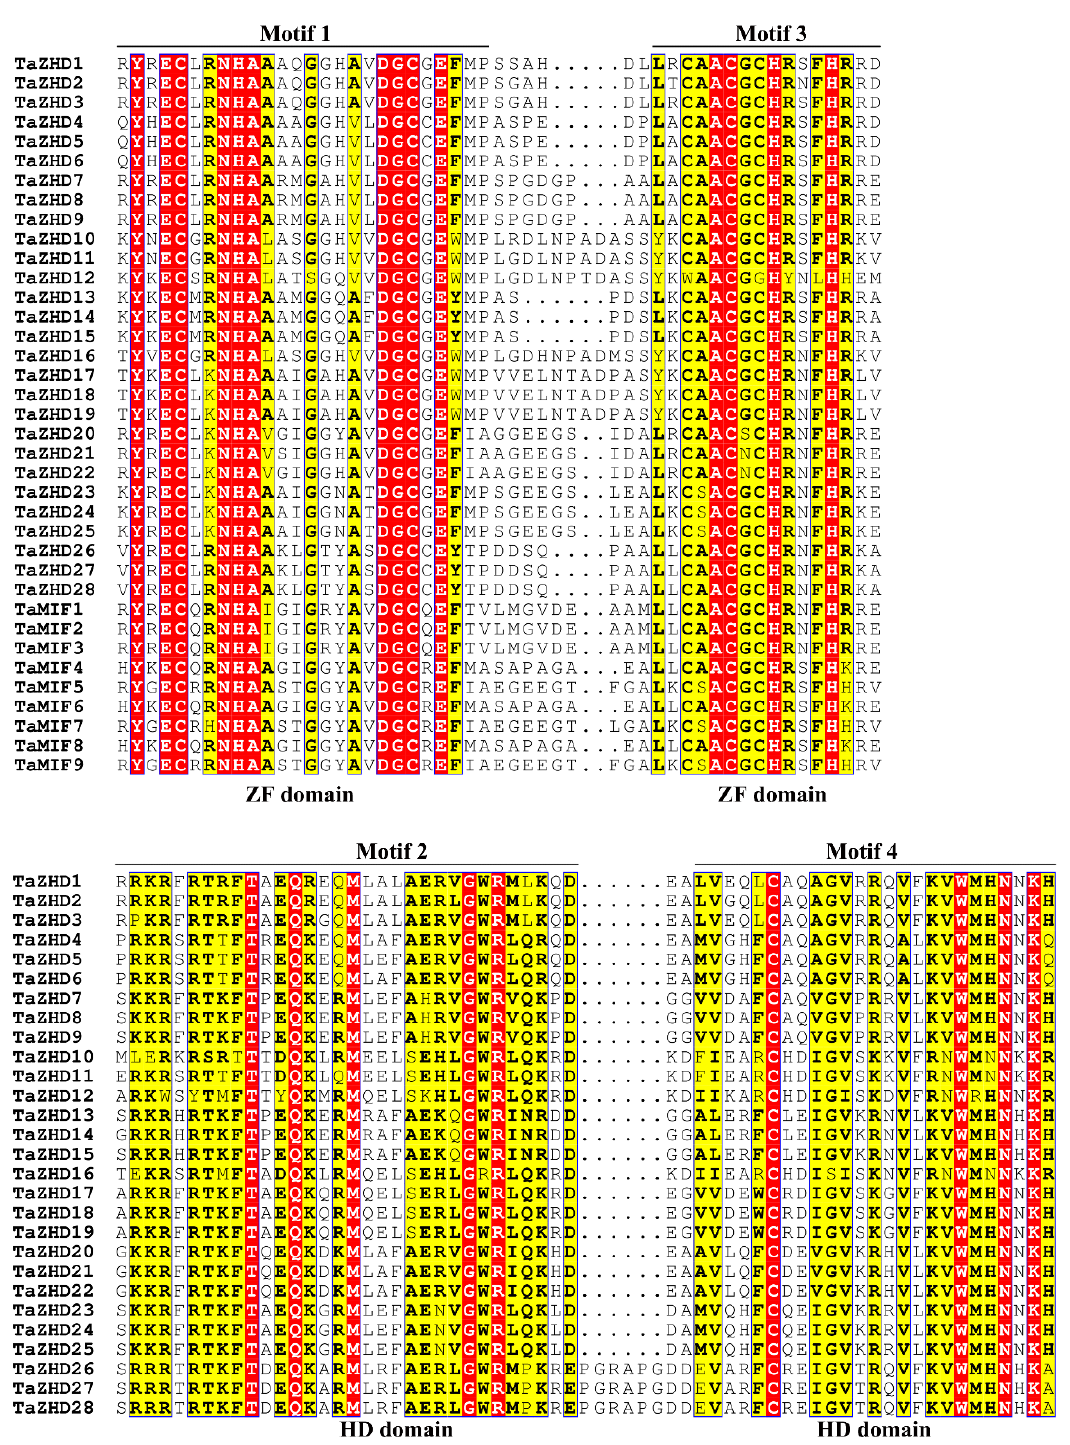
Figure 3. Multiple sequence alignment of the conserved domains of the members of the TaZF-HD gene family in wheat. Motifs 1 and 3 were ZF domains and motifs 2 and 4 were HD domains.